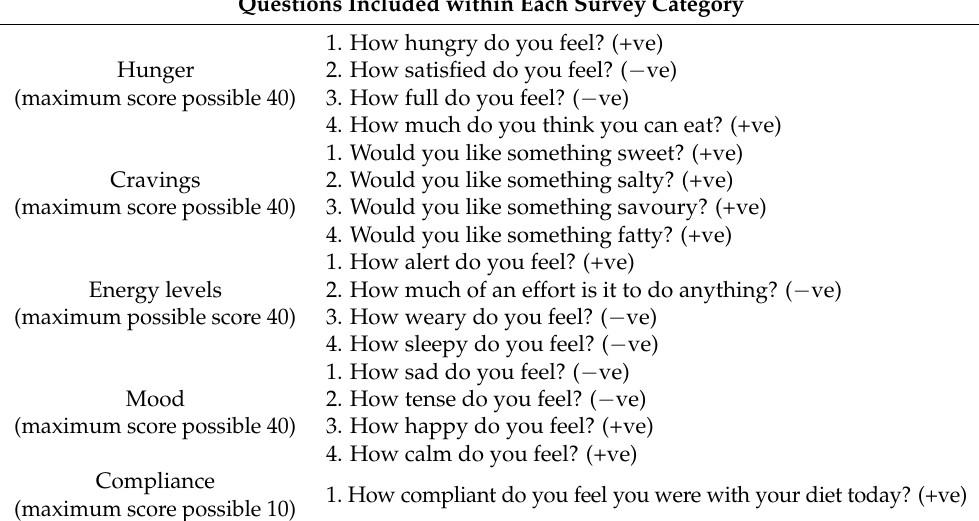
Table 1. Questions included within each survey category for hunger, cravings, mood and energy